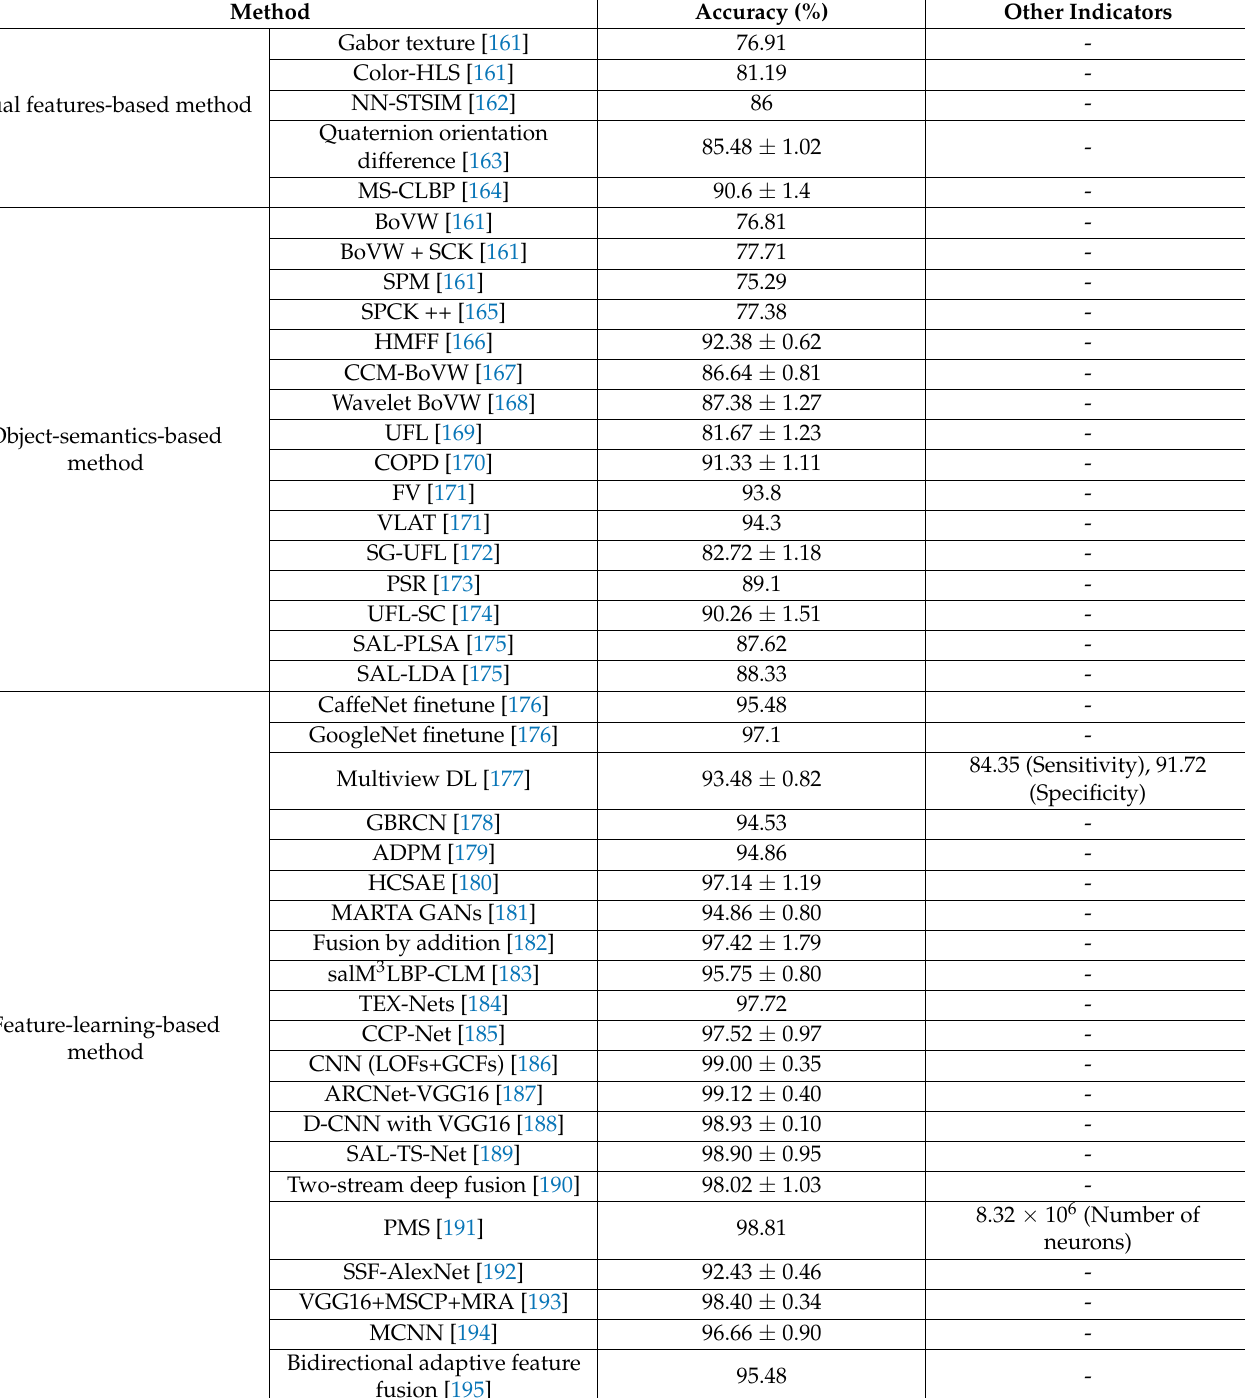
Table 4. Comparison of main methods in geographic scene